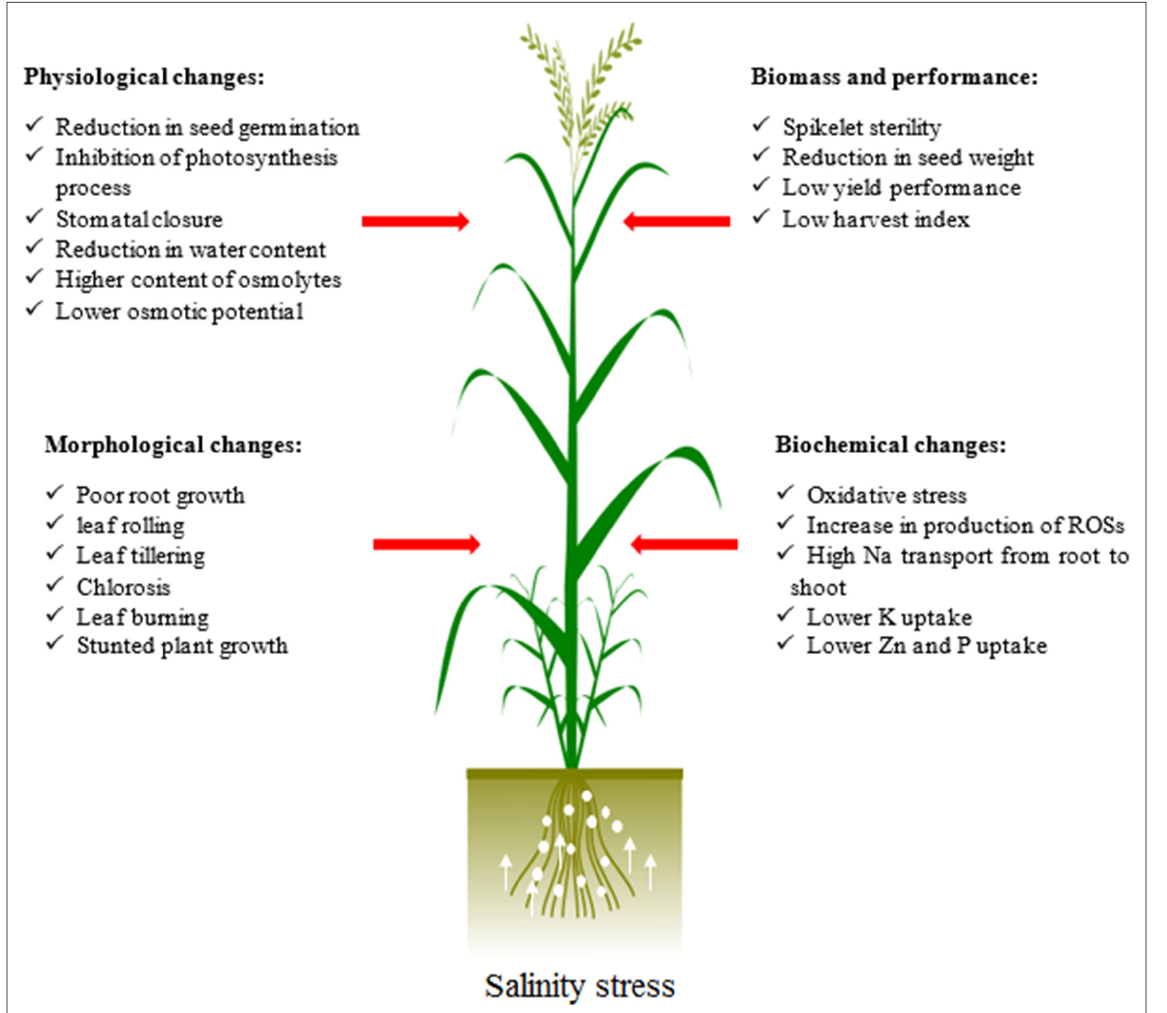
Figure 2. Effect of high salt concentration on various aspects of plant growth and developmental stages.